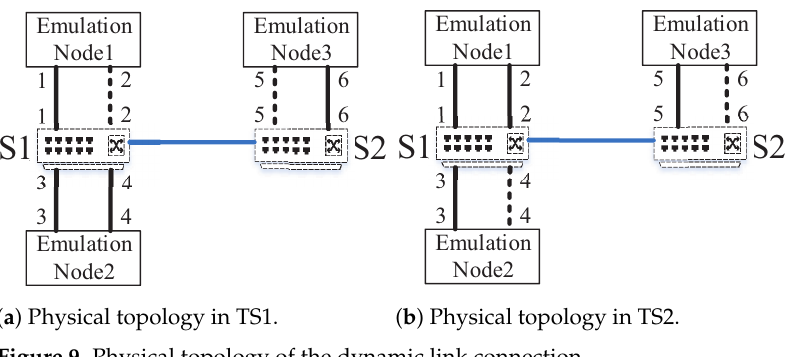
Figure 9. Physical topology of the dynamic link